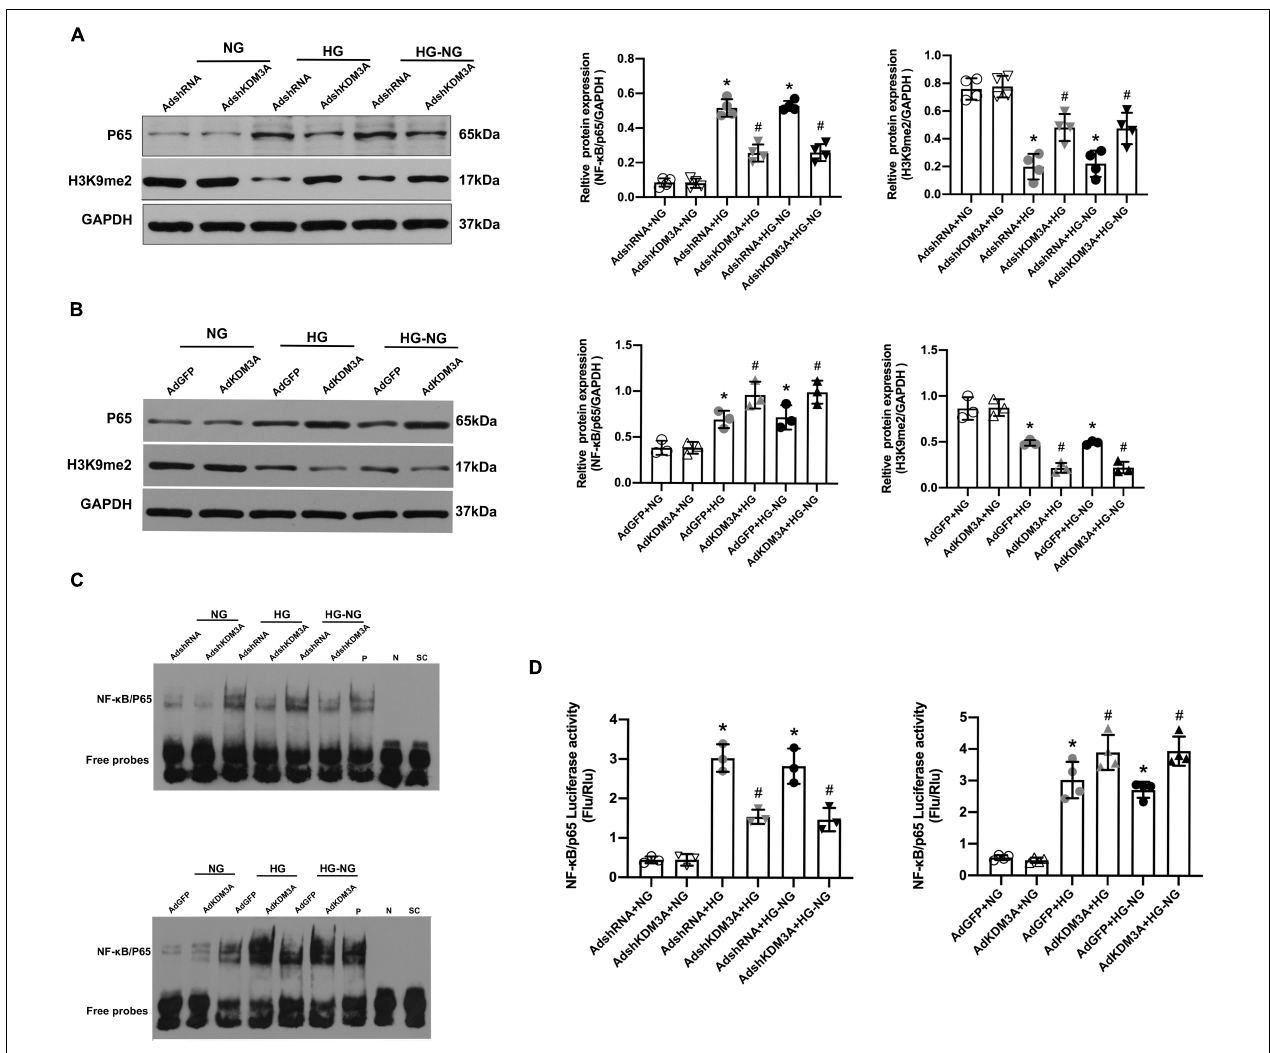
FIGURE 3 | KDM3A modulates the expression and transcriptional activity of NF- κ B/P65 in high glucose-induced persistent cardiomyocytes dysfunction. The primary cardiomyocytes were treated with HG 72 h or HG 24 h to NG 48 h (HG–NG) after the transfection with recombinant adenovirus vectors for 48 h, including AdshRNA, AdKDM3AshRNA, AdGFP, and Ad-KDM3A. (A,B) The protein levels of P65 and H3K9me2 were analyzed by western blot after down- or up-regulating the expression of KDM3A by adenovirus transfection ( n = 4). (C) Furthermore, EMSA was used to assess the DNA binding activity of NF- κ B in cardiomyocytes under different conditions. (D) To identify whether KDM3A directly targets NF- κ B, the dual-luciferase reporter gene assay was conducted after down- or up-regulating the expression of KDM3A ( n = 3). * p < 0.05, as compared to the AdshRNA + NG or AdGFP + NG; # p < 0.05, as compared to the AdshRNA + HG or AdshRNA + HG–NG, AdGFP + HG or AdGFP +